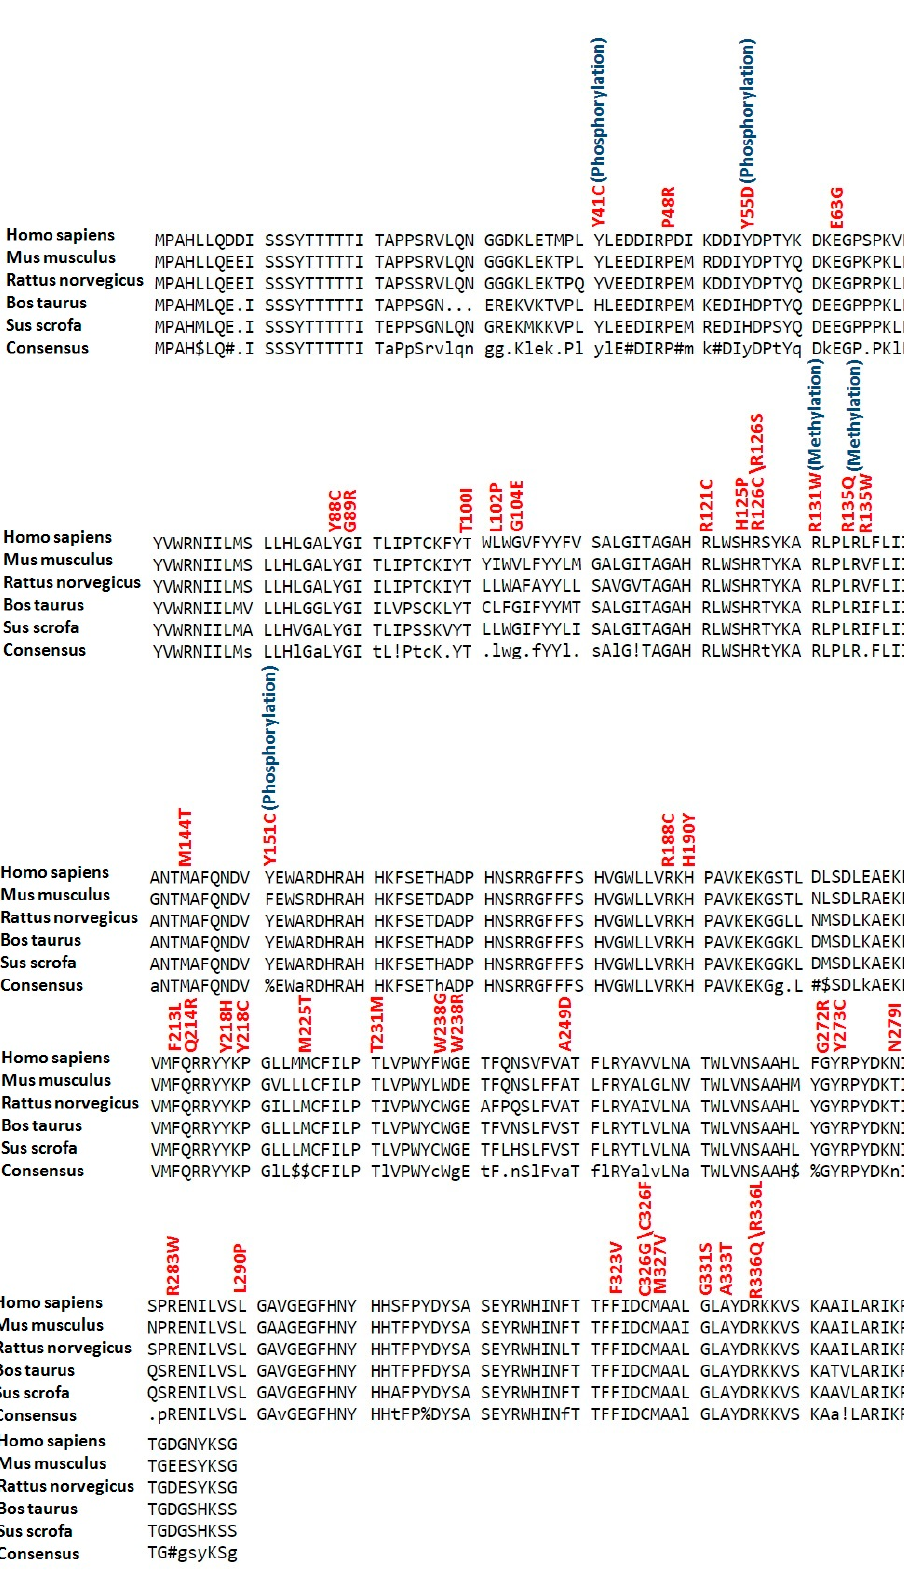
Figure 5. Conservation analysis of potential modified residues in SCD1 protein. Sequences of SCD1 proteins (human, mouse, rat, cattle and pig) were aligned using Multalin version 5.4.1 (http://multalin.toulouse.inra.fr/multalin/). High risk deleterious missense SNPs are mentioned in red color at respective positions while overlap with various types of posttranslational modifications are given in blue color.